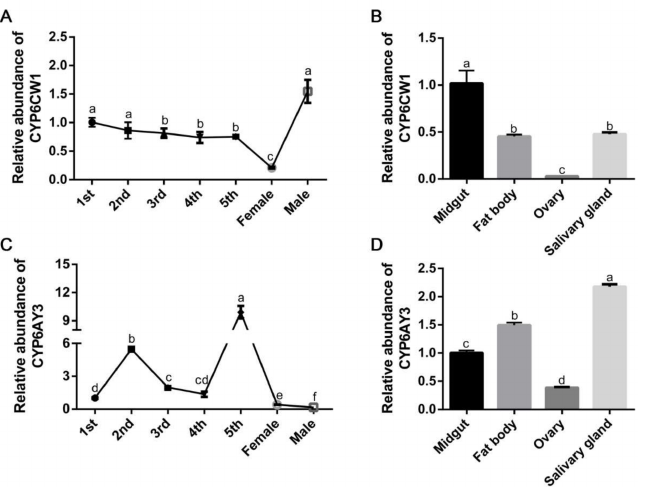
Figure 4. The expressions of CYP6CW1 and CYP6AY3 in different developmental stages and different tissues of L. striatellus . ( A , B ) Analysis of CYP6CW1 expression at developmental stages ( A ) and different tissues ( B ) by RT-qPCR. VF L. striatellus from 1st-instar to adult were collected as samples at developmental stages. The fat body, midgut, ovary, and salivary gland of L. striatellus were dissected from VF adults of L. striatellus under microscope. ( C , D ) Analysis of CYP6AY3 expression at developmental stages ( C ) and different tissues ( D ). The letters a, b, c, d, e, and f represent significant differences ( p < 0.05). The conditions within a graph that share the same letters were not significantly